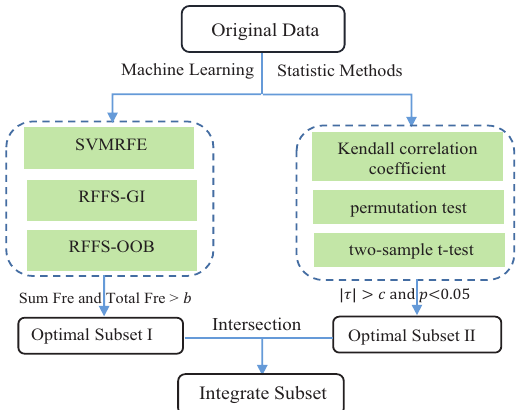
Figure 1. The flowchart of the hybrid feature selection method. Fre denotes frequency, τ the Kendall correlation coefficient, p the p -values of test and b and c the given constants. In which, SVMRFE refers to support vector machine based on recursive feature elimination, RFFS-GI refers to the feature selection with random forest by Gini importance and RFFS-OOB refers to the feature selection with random forest by the classification accuracy on the OOB